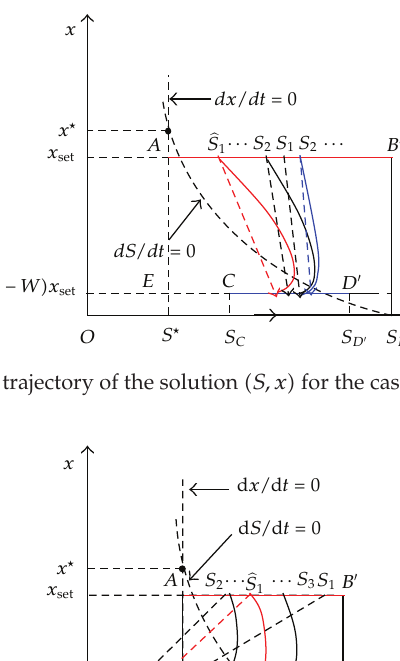
Figure 7: The trajectory of the solution (cid:5) S,x (cid:6) under sequence (cid:5) c (cid:6)